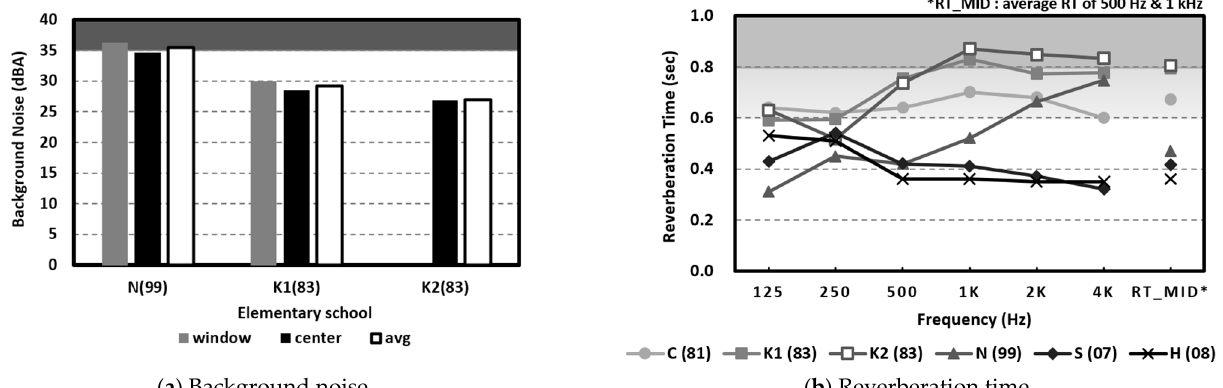
Figure 1. Location of sound source and receiving points for measurement in the elementary classroom.